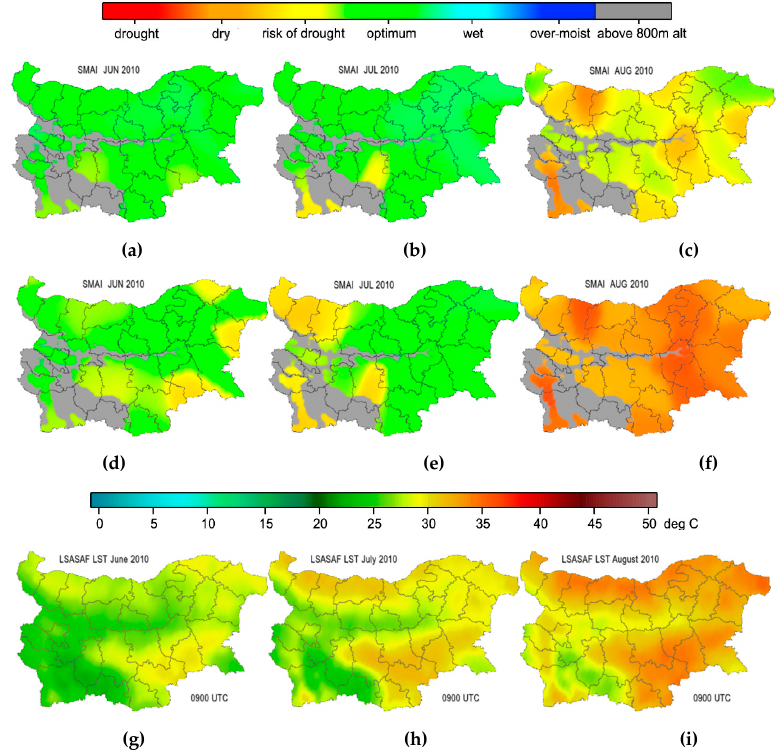
Figure 5. Spatial distribution of SMAI (50 cm soil layer) monthly mean over Bulgaria in 2010 for ( a ) June, ( b ) July, and ( c ) August, and of SMAI (20 cm soil layer) for ( d ) June, ( e ) July, and ( f ) August. LSASAF LST for ( g ) June, ( h ) July, and ( i )